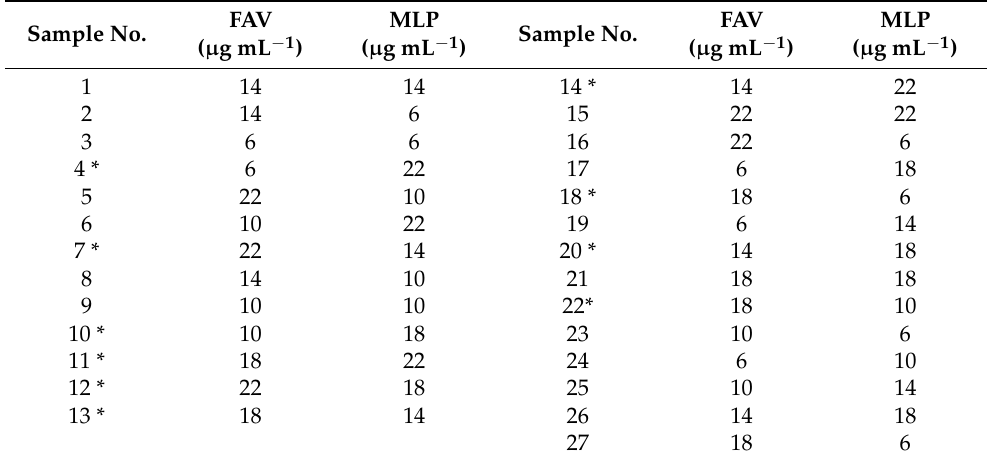
Table 1. Concentrations of calibration and validation sets mixtures of FAV and MLP used in the chemometric